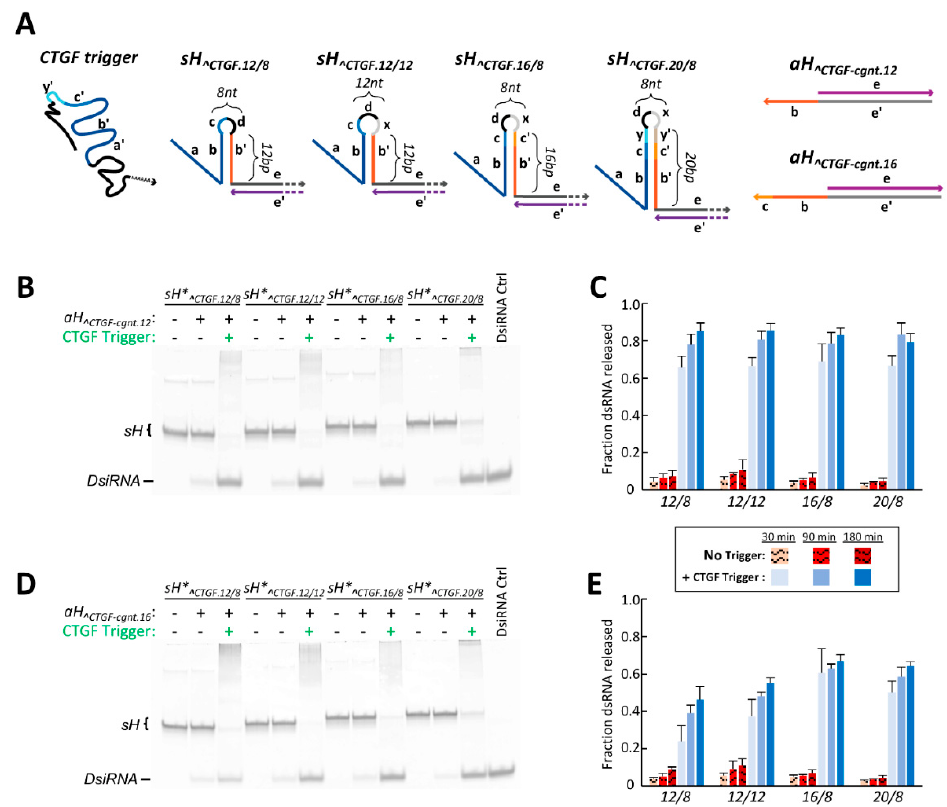
Figure 4. E ff ects of DNA structural alteration on the degree of trigger-inducible dsRNA release. ( A ) Four di ff erent sense hybrids that are responsive to the connective tissue growth factor (CTGF) trigger were designed, each having di ff erent features within the structured DNA hairpin. The hairpins di ff ered in the size of their loop or the length of their stem. Two di ff erent cognate antisense hybrids were designed and di ff er in the length of their single-stranded toehold. Sequence regions are indicated by lowercase letters and di ff erent colors to convey sequence identity or sequence complementarity. ( B , D ) DsiRNA release in the presence and absence of trigger was assessed by 10% acrylamide non-denaturing PAGE for each sense hybrid paired with a cognate antisense hybrid exhibiting either ( B ) a 12 nt toehold ( aH ˆCTGF-cgnt.12 ) or ( D ) a 16 nt toehold ( aH ˆCTGF-cgnt.16 ). Each sense hybrid and the DsiRNA control contained a 3 (cid:48) 6-carboxyfluorescein (6-FAM) labeled sense RNA strand for visualization and quantification. Gels in both ( B ) and ( D ) depict samples that were incubated for 30 min at 37 ◦ C. ( C , E ) Analysis of the fraction of dsRNA released by the four sense hybrids paired with ( C ) aH ˆCTGF-cgnt.12 or ( E ) aH ˆCTGF-cgnt.16 , in the presence and absence of the RNA trigger following 30, 90, or 180 min incubations at 37 ◦ C. Error bars indicate standard deviation of three replicate